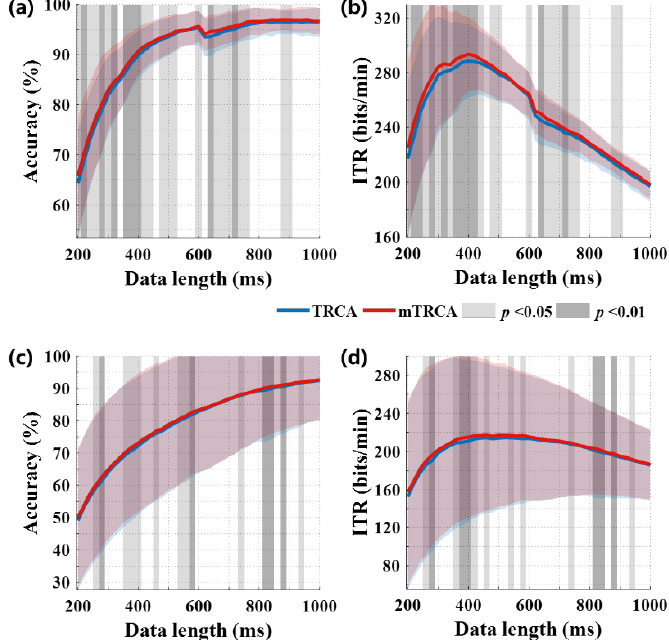
Figure 7. The recognition accuracies ( a , c ) and information transfer rates (ITRs) ( b , d ) using data from the offline experiments ( a , b ) and the benchmark dataset ( c , d ), respectively. The lines with deep color represent the averages while the shadings with light color represent standard deviation. The grey shading shows the significance of difference between accuracies of two spatial filters (Wilcoxon signed-rank test).